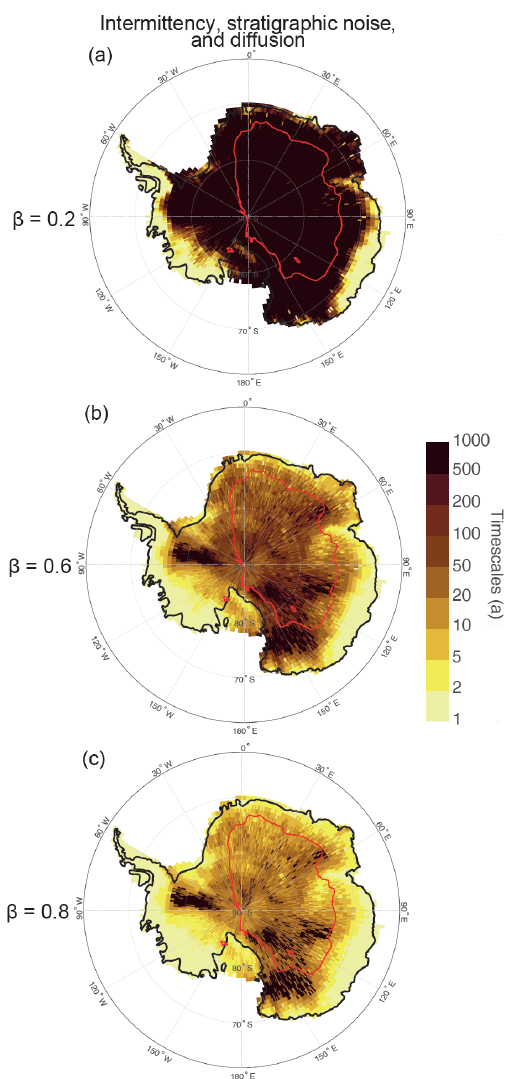
Figure 9. Maps of the signal retrieval timescales τ a after block av- eraging including the effects of precipitation intermittency, strati- graphic noise corresponding to 60% of the climatic signal’s vari- ance, diffusion, and additional measurement noise of 0.1‰ 2 (total variance), assuming climate spectrum scaling exponents of (a) β = 0 . 2, (b) β = 0 . 6, and (c) β = 0 . 8. The red line marks the contour of an accumulation of 25cmw.e.; see also Fig.